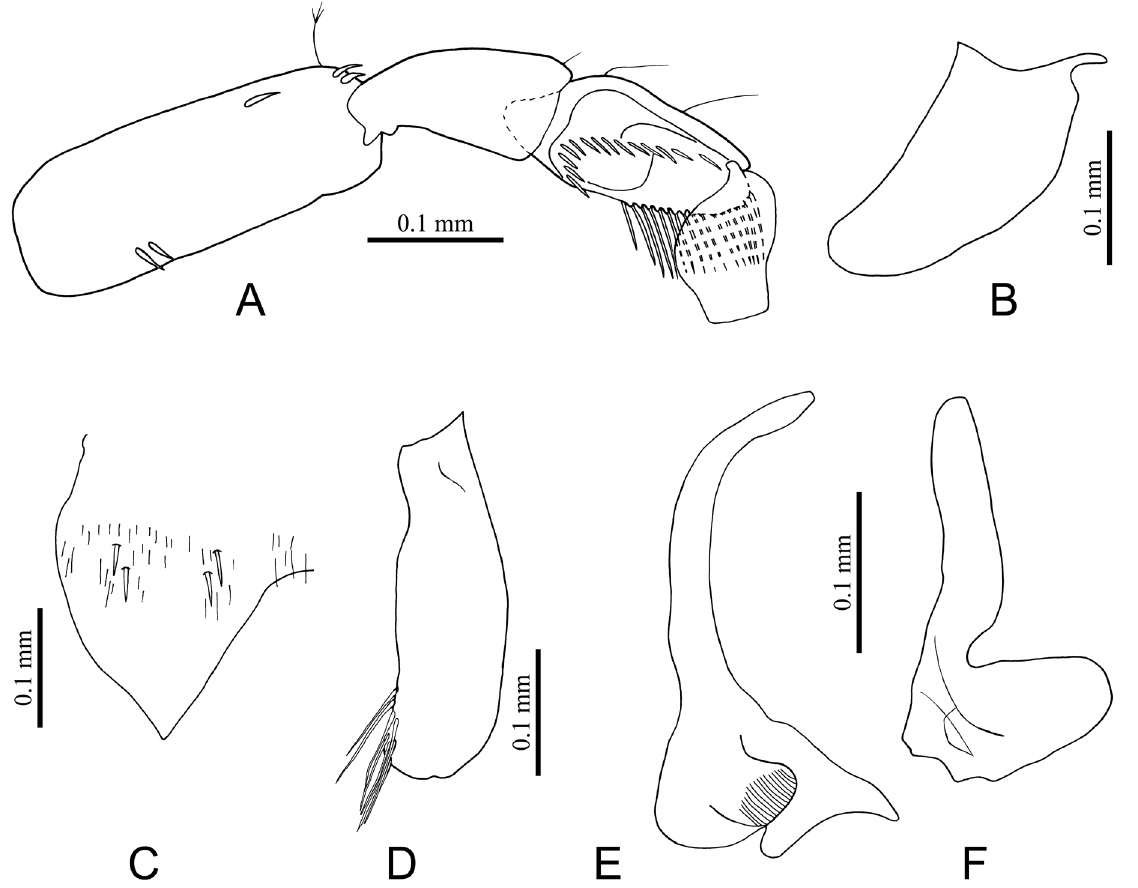
Fig. 12. Morphological features of Micronecta vietnamica sp. nov., ♂, paratype (ZVNU). A . Fore leg. B . Prestrigilar flap. C . Median lobe of sternite VII. D . Free lobe. E . Right paramere. F . Left